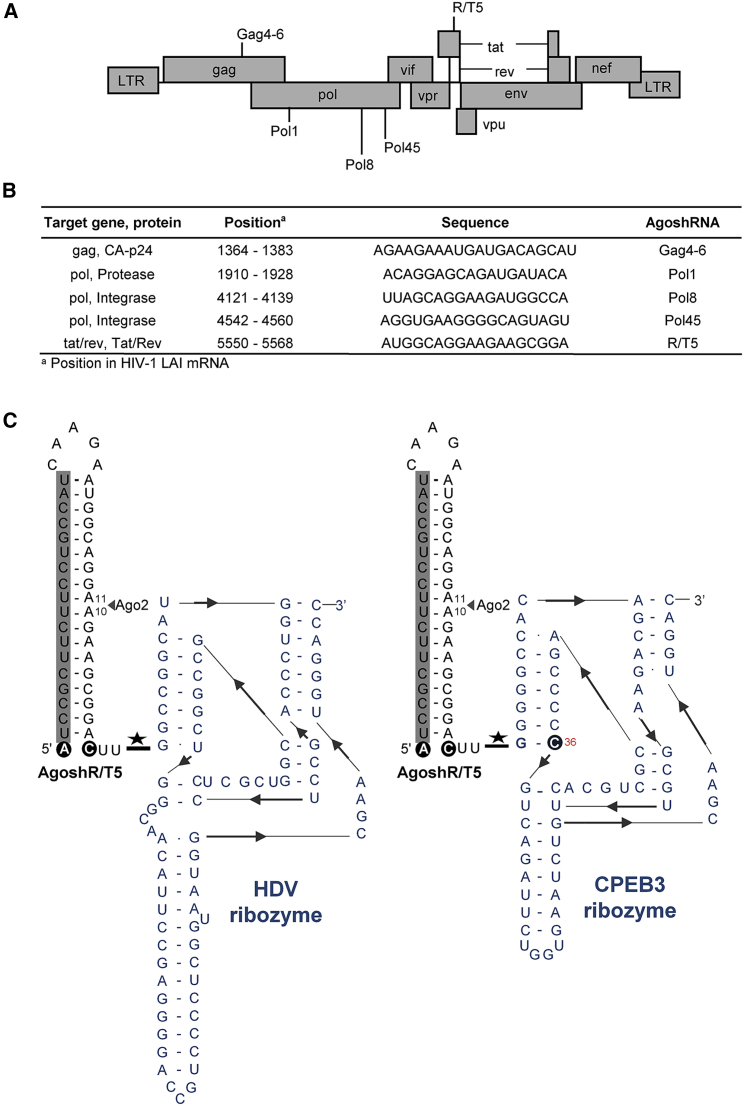
Design of Anti-HIV AgoshRNAs(A) The HIV genome showing the position of all target sites. (B) HIV target sequences that are highly conserved among HIV isolates. (C) Secondary structure of the R/T5 AgoshRNA with a 3′ terminus ribozyme, as predicted by Mfold, with the guide strand boxed shaded in gray. The Ago2 cleavage site is indicated by a black triangle (bp 10–11). The 5′ end nucleotide of AgoshRNA constructs and the base-pairing partner were replaced by A C (black circle). Hepatitis delta virus (HDV) and cytoplasmic polyadenylation element-binding protein (CPEB3) ribozymes (shown in blue) were inserted immediately downstream of the CUU 3′ terminus. The variable position 36 in the CPEB3 ribozyme is circled in blue. The ribozyme cleavage site is indicated by a star.